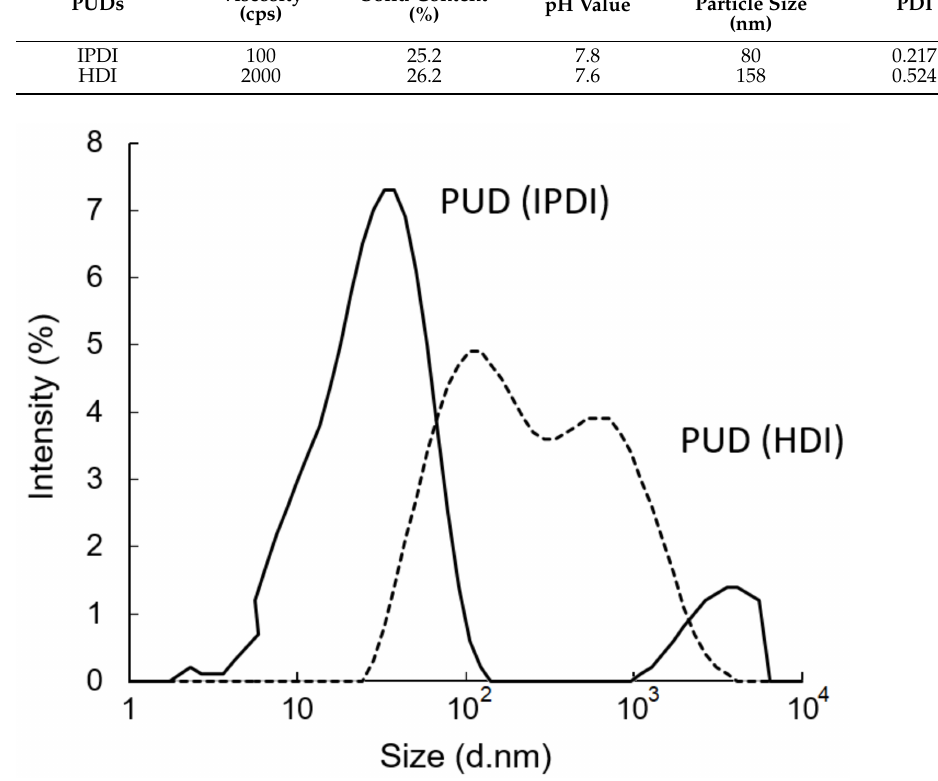
Figure 13. Particle size distributions of